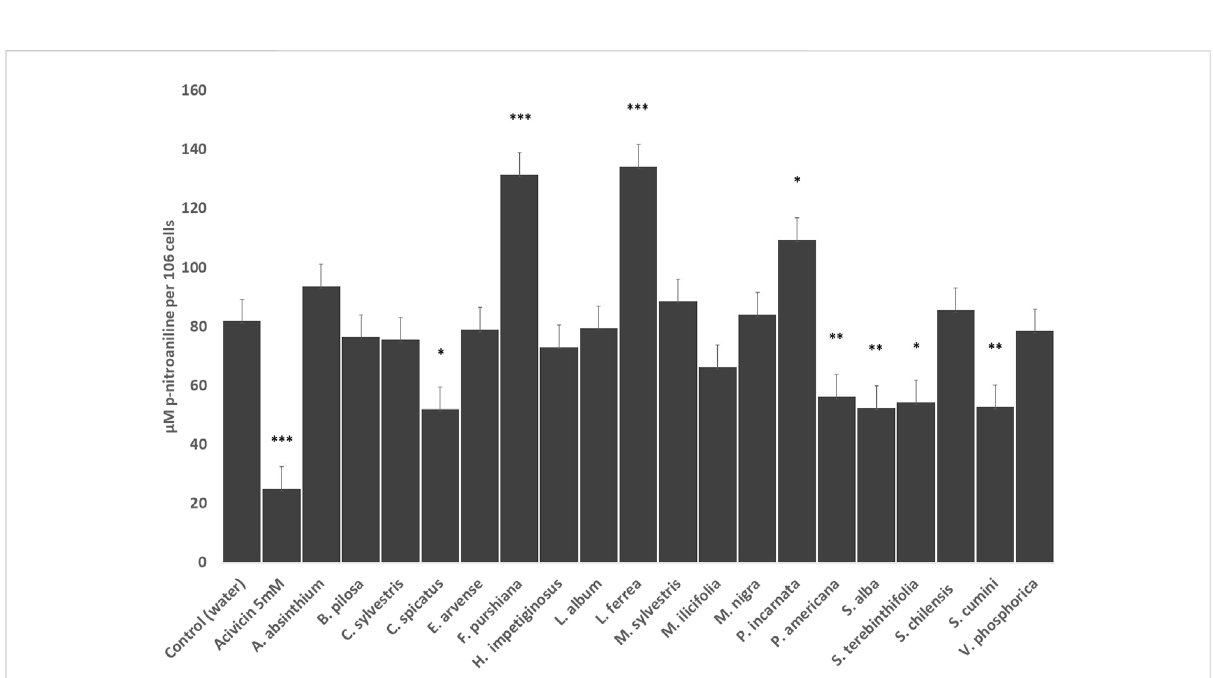
FIGURE 3 Effects of the selected herbal preparations (100 μ g/ml) and Acivicin (5 μ M, positive reference treatment) on the surface enzymatic activity of GGT of HEPG2 cells (Mean ± SEM, n ≥ 3). Statistical signi fi cance against water (control) according to Bonferroni (* p < 0.05, ** p < 0.01, *** p <